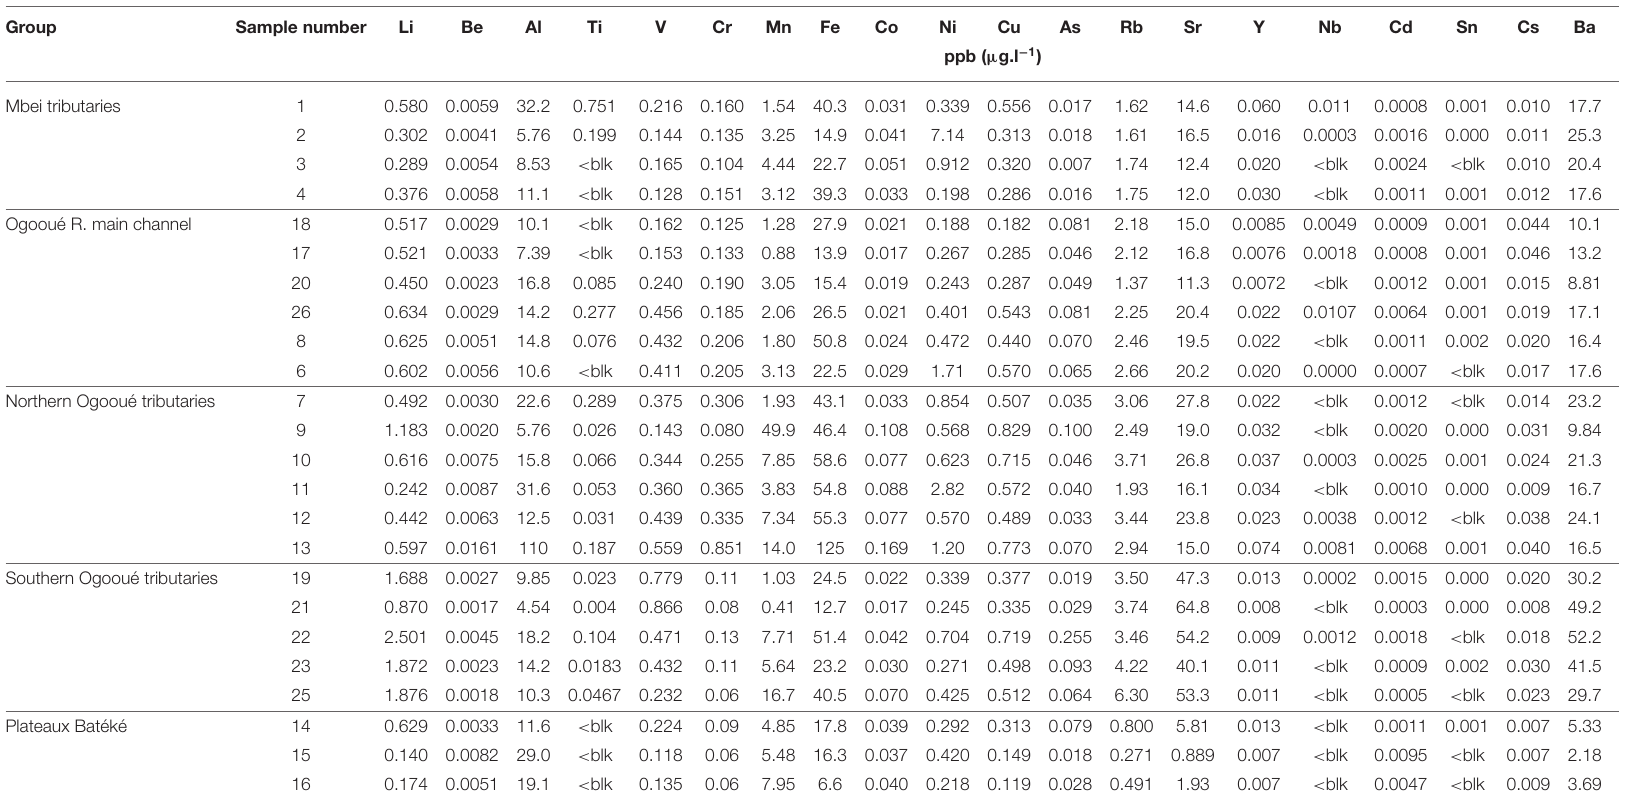
TABLE 3 | Concentration (in ppb or µ g.l − 1 ) of trace elements in the dissolved phase (i.e., < 0.22 µ m) of the Ogooué and Mbei basins.